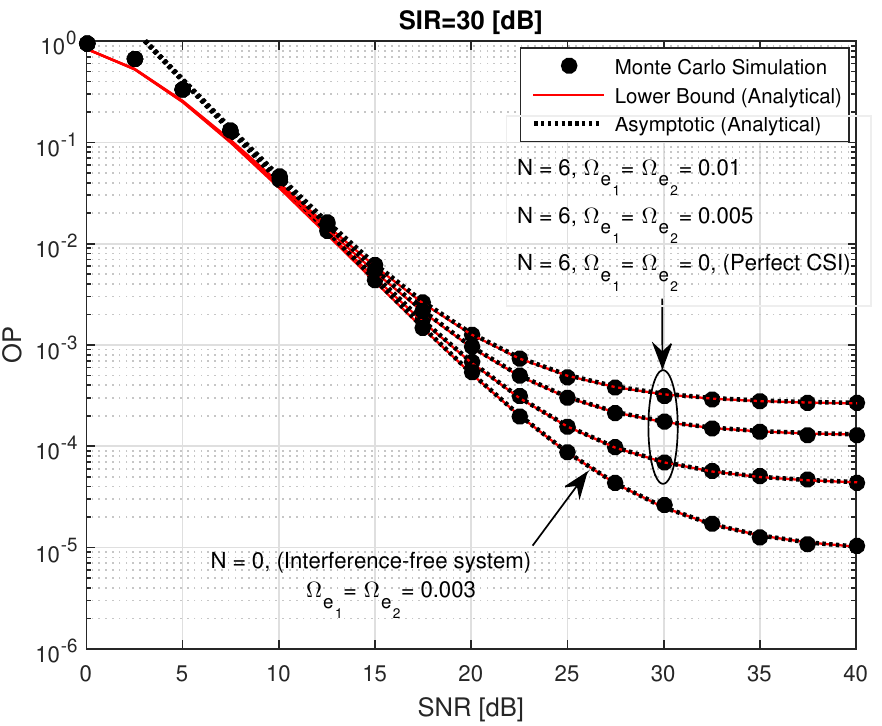
Figure 9. System outage probability of AF-TWRN with CCI and different CEE values, γ th = 0 dB and L 1 = L 2 = 2.